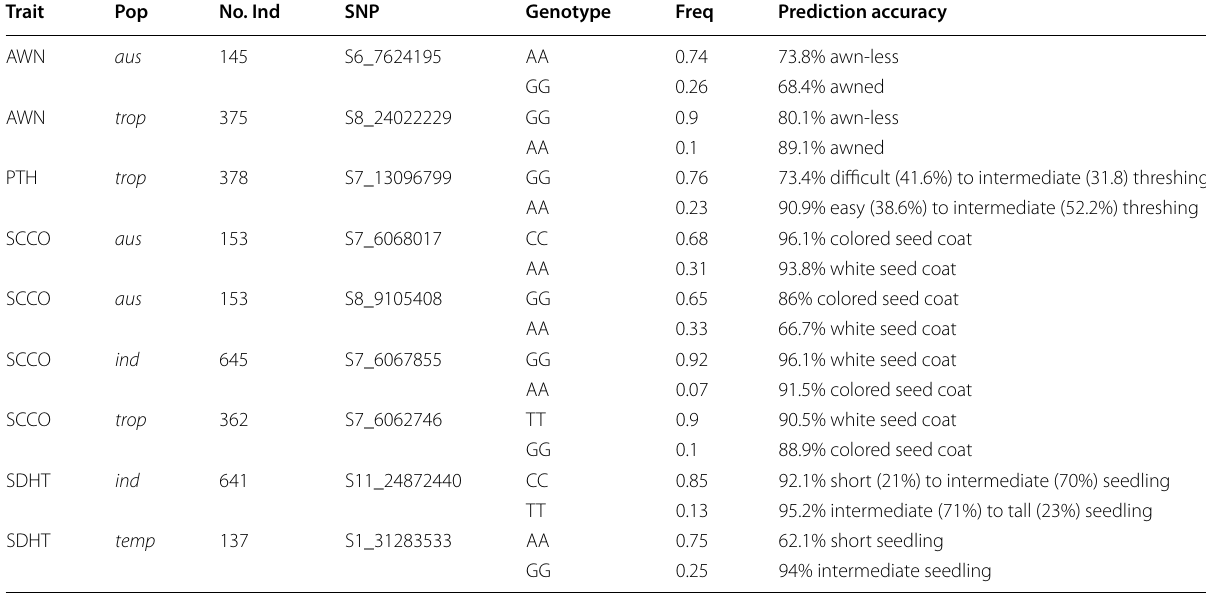
The meaning for each trait abbreviation is as follows: AWN: awn color; PTH: panicle threshability, SCCO: seed coat color; SDHT: seedling height. Sub-population combinations are shown in the table if the genotype of trait-associated SNP can predict the phenotype with at least 60% of chance to accuracy. Otherwise we do not present the Sub-population trait combinations for a clear and concise ×